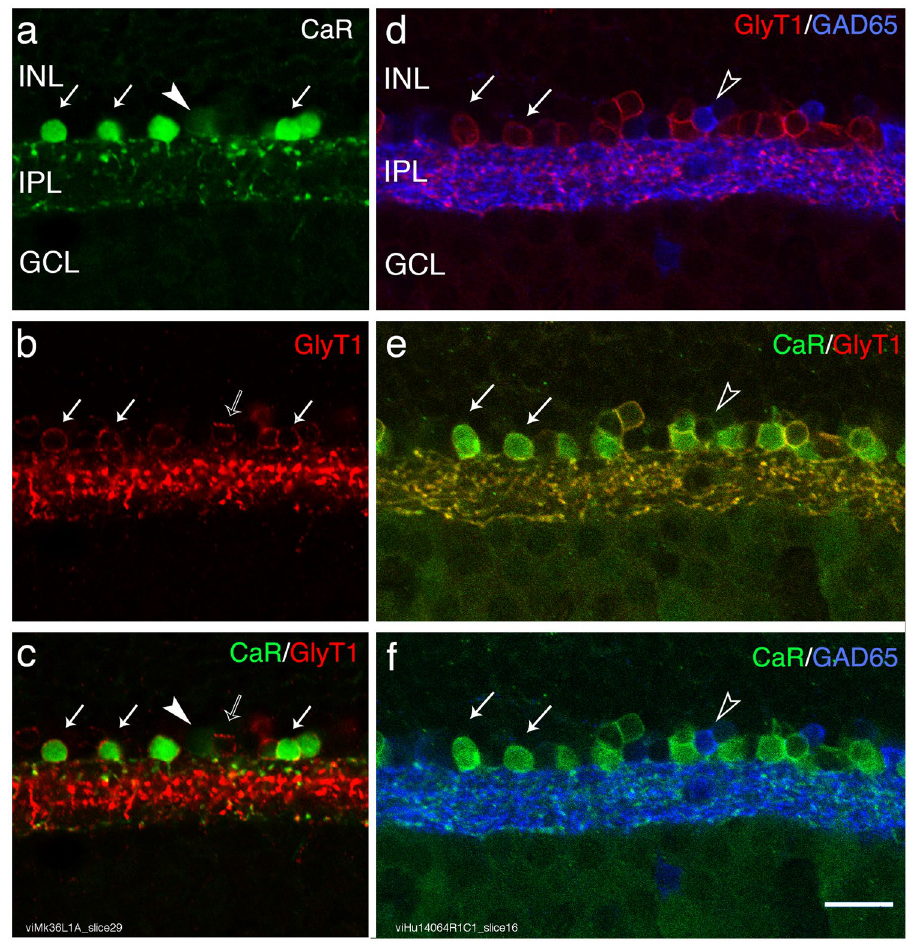
Figure 1. The majority of calretinin positive amacrine cells is glycinergic. ( a–c ) Macaque retina: Confocal images of a vibratome section through central retina processed with antibodies against calretinin (CaR, green) and antibodies against glycine transporter 1 (GlyT1, red). The white arrows indicate double labelled cells, the arrowhead points to a calretinin positive/GlyT1 negative cell and the open arrow point to a GlyT1 positive/CaR negative cell. ( d–f ) Human retina: Confocal images of a vibratome section through central retina processed with antibodies against calretinin (CaR, green), antibodies against glycine transporter 1 (GlyT1, red), and antibodies against glutamic acid decarboxylase (GAD, blue). The open arrowheads indicate a GAD positive/ CaR positive cell. INL, inner nuclear layer; IPL, inner plexiform layer; GCL, ganglion cell layer. Scale bar shown in f = 20 µ m (valid for a–f